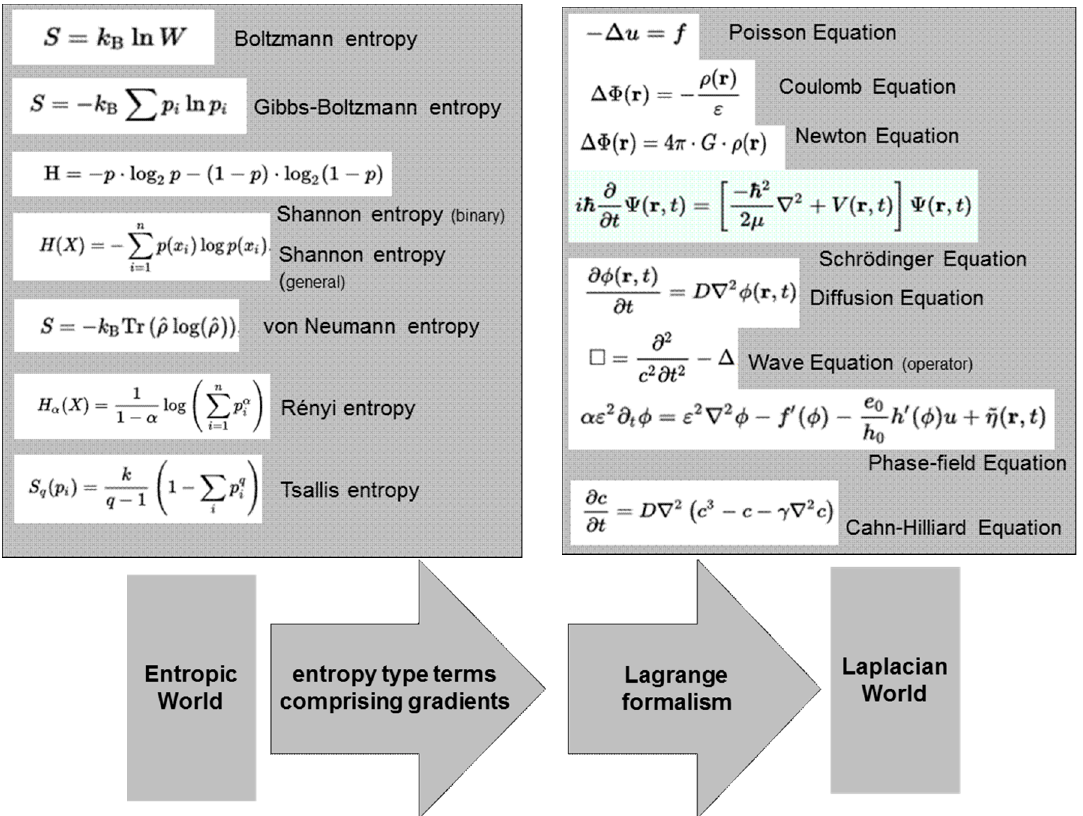
Figure 8. Upper left : Incomplete list of models for a statistical/entropic description of entities in physics and in information theory. Most of these models reveal a logarithmic term as a common ingredient. None of these expression comprises gradients and/or Laplacian operators. Upper right : Incomplete list of models for a spatio-temporal description of stationary solutions or for the evolution in physics systems. Many of these models have a Laplacian operator as a common ingredient. Bottom : Entropy formulations comprising gradients as depicted in the present paper provide a bridge between these two model